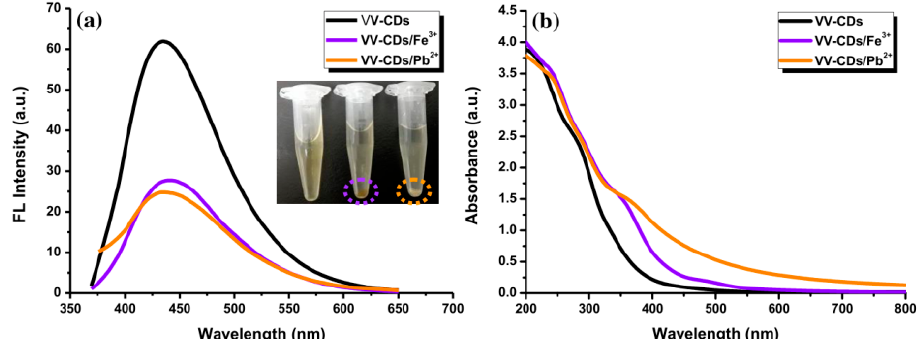
Figure 8. ( a ) The FL emission excited at 360 nm and ( b ) UV-Vis spectra of VV-CDs (black line), VV-CDs / Fe 3 + (purple line), and VV-CDs / Pb 2 + (orange VV-CDs/Fe 3+ (purple line), and VV-CDs/Pb 2+ (orange line).